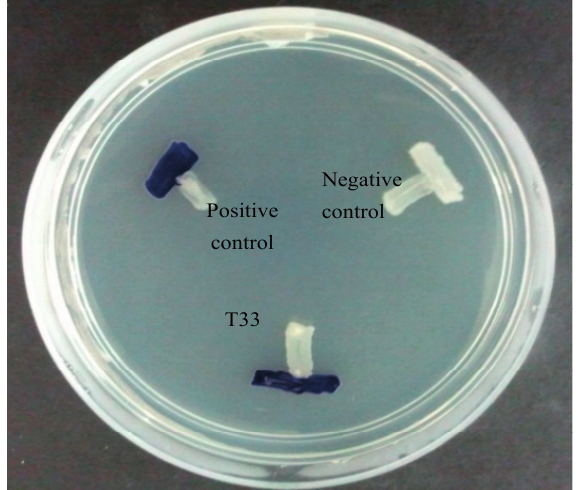
Figure 1. AHL screening of strain T33 with C. violaceum CV026. E. carotovora PNP22 (negative control) devoid of QS activity was included and E. carotovora GS101 (positive control) that can activate CV026 was included for comparison.